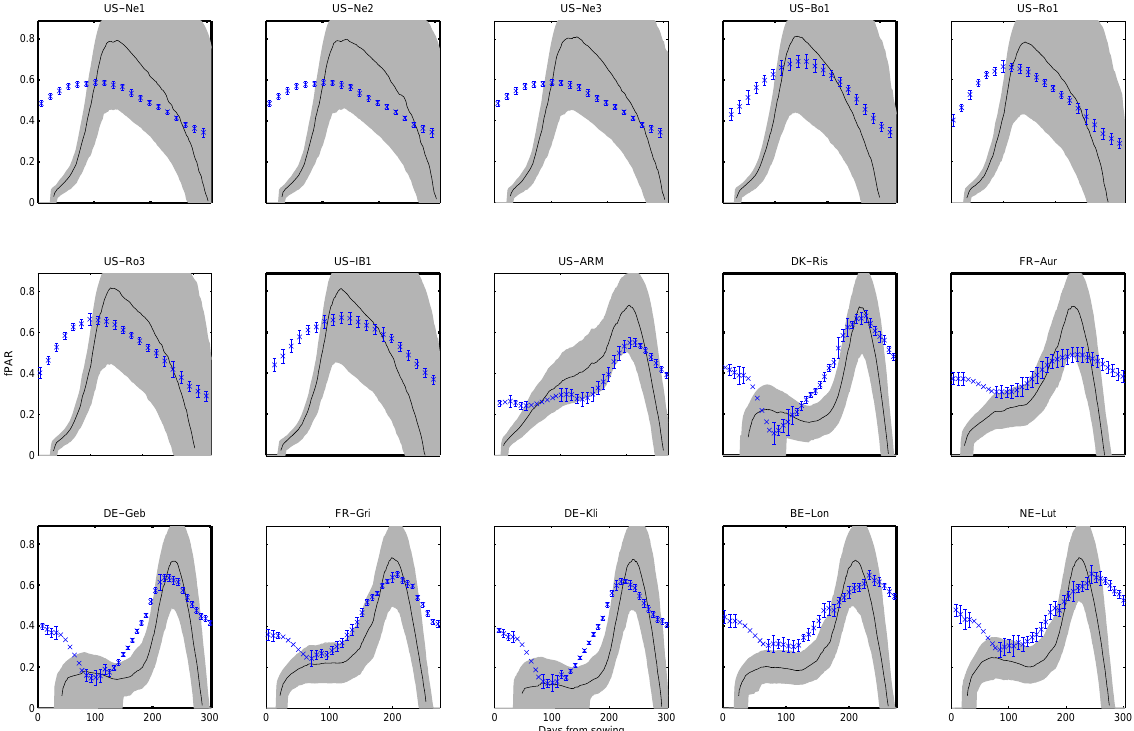
Figure A5. fAPAR predictions for 1 year for all sites fitted using all available data at a subset of sites for model evaluation. Sites with black boxes have been used in the model fitting. Grey shaded areas represent 95% confidence intervals drawn from the posterior distribution.